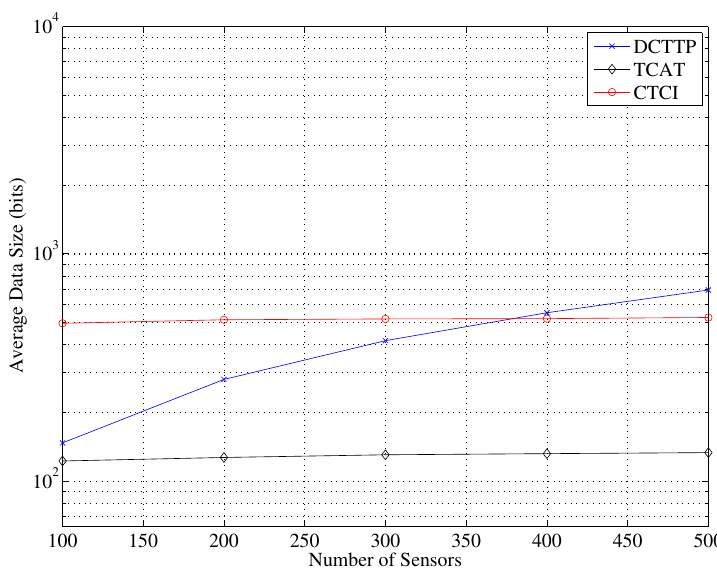
Figure 15. Impact of the number of sensor nodes on the average data size.